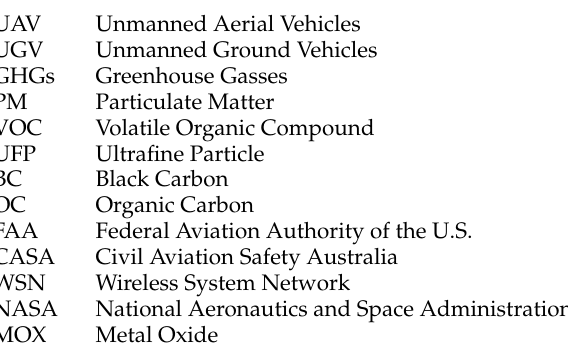
Table S1: Search terms, Table S2: Summary of the lightweight UAV onboard technology for air quality